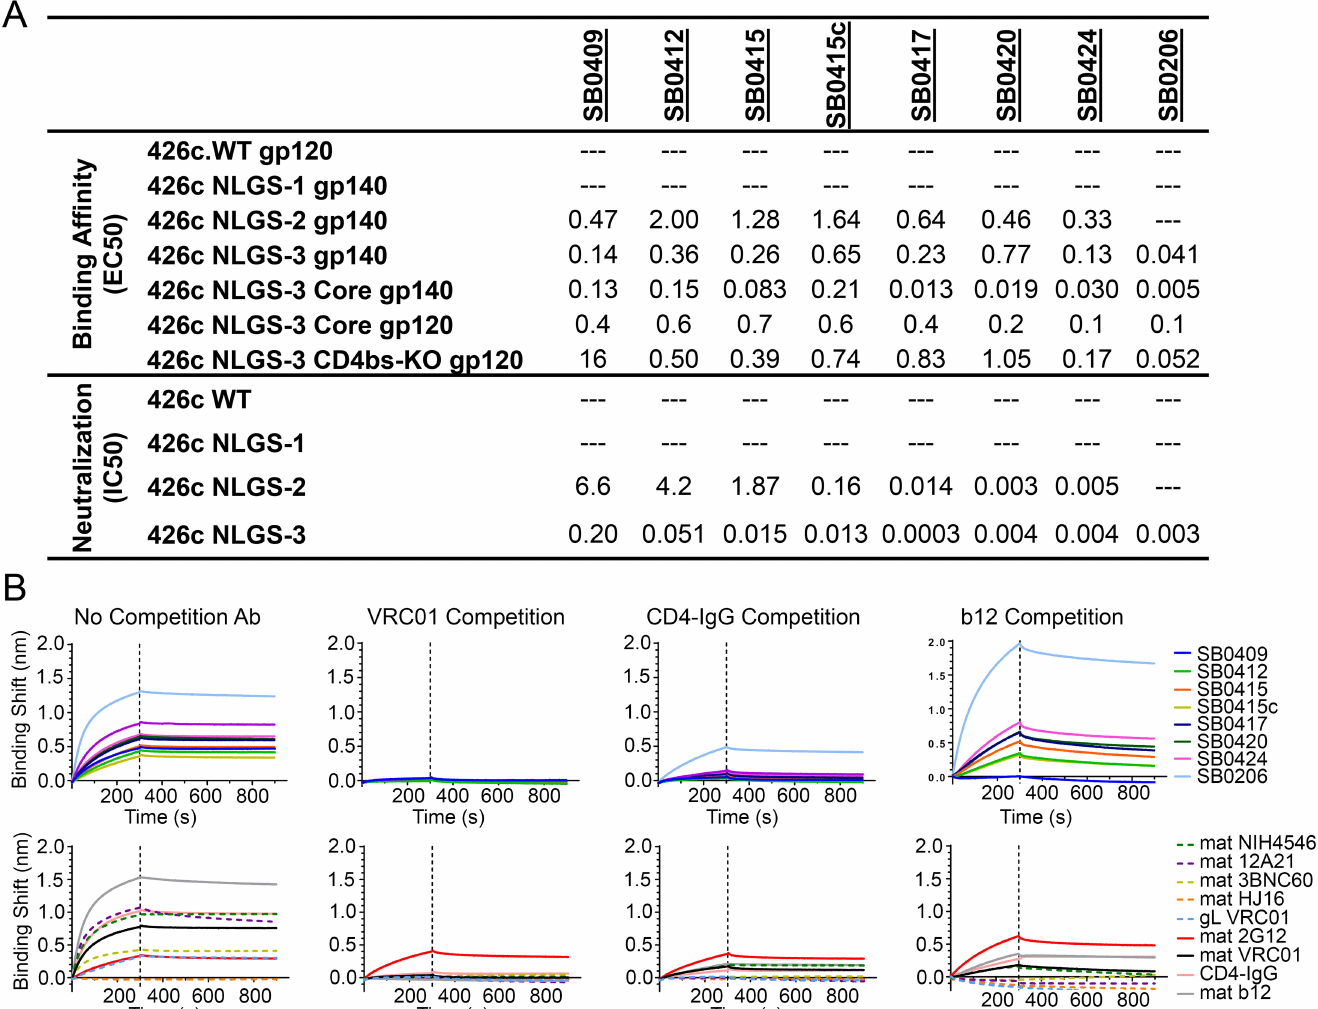
PLOS Pathogens| https://doi.org/10.1371/journal.ppat.1007120 June 22,